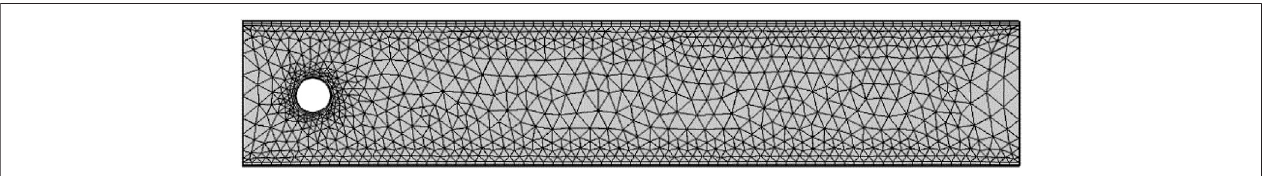
FIGURE 2 | Hybrid grid structure at a fi ne level.